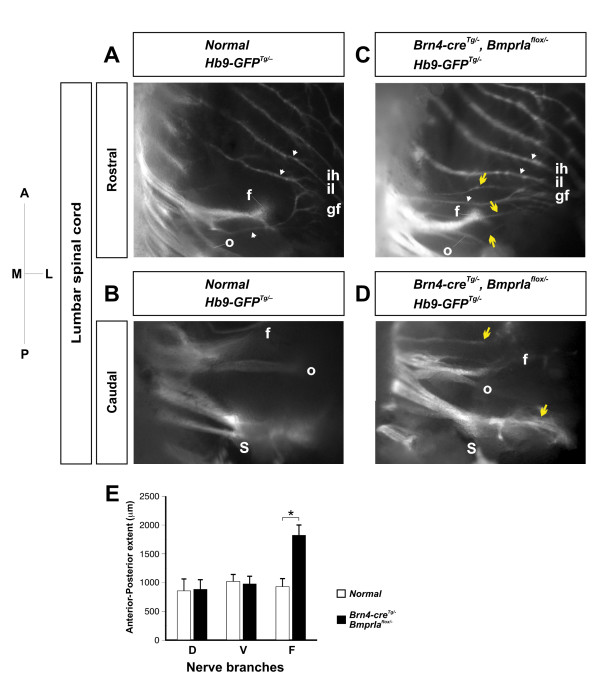
Lumbar spinal cord motor axon projections to the ventral flank. (a-d) E13.5 normal and BmprIaflox/- embryos carrying an Hb9-GFP transgene imaged via indirect fluorescence. The embryos were eviscerated and the ventral abdominal wall was reflected to allow examination from a peritoneal aspect. Images of rostral (a,c) and caudal (b,d) regions are of different embryos, and in the caudal images the more rostral (for example, genitofemoral) nerves were removed during the dissection. In control embryos three major motor nerves (white arrows) project abdominally via the ventral flank from rostral segments of the lumbar spinal cord (a), while none project abdominally from more caudal segments (b). The limb nerves (f, femoral nerve; o, obturator nerve; S, sciatic plexus) turn along dorsal or ventral limb trajectories into the plane of the image. In mutant embryos, additional flank-projecting nerves (yellow arrows) are present at both rostral (c) and caudal (d) levels. (e) Quantification of nerve trajectories at E11.5–11.75. Transverse sections of normal and BmprIaflox/- embryos carrying an Hb9-GFP transgene were scored for the presence of a GFP+ dorsal limb, ventral limb or ventral flank nerve branch. The combined continuous anteroposterior extent of sections containing nerves following each trajectory is presented. gf, genitofemoral nerve; ih, iliohypogastric nerve; il, ilioinguinal nerve. M, medial; L, lateral; A, anterior; P, posterior.